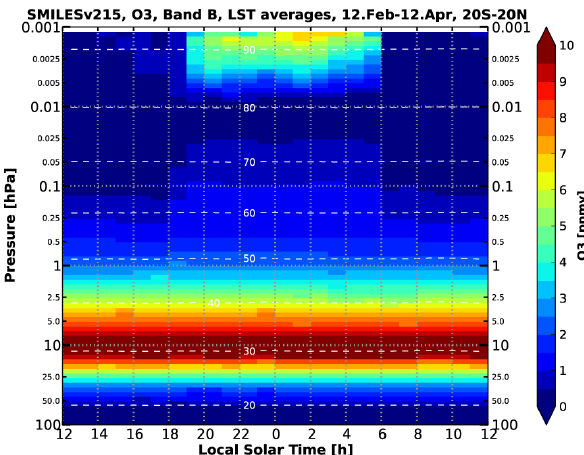
Fig. 26. Diurnal variation of O 3 VMR in ppmv in the stratosphere and mesosphere are shown for the equatorial region 20 ◦ S–20 ◦ N. The SMILES profiles are binned to 1h LST bins and plotted verti- cally against